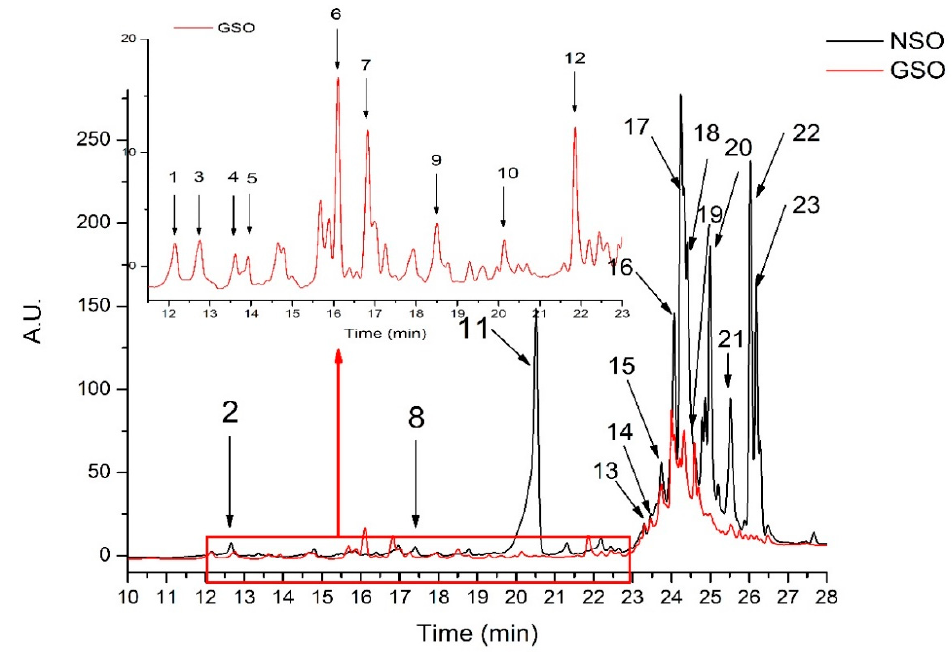
Figure 2. Comparative HPLC chromatograms of NSO and GSO. For peak assignment, see Table 4.